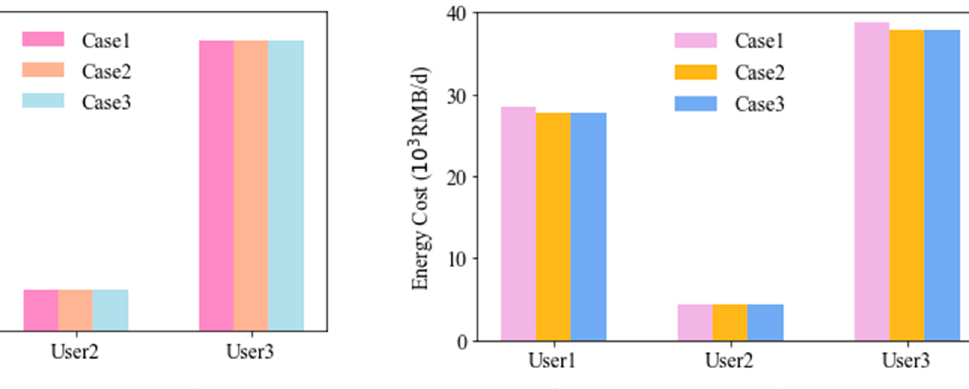
Figure 12. The benefits of users in winter.